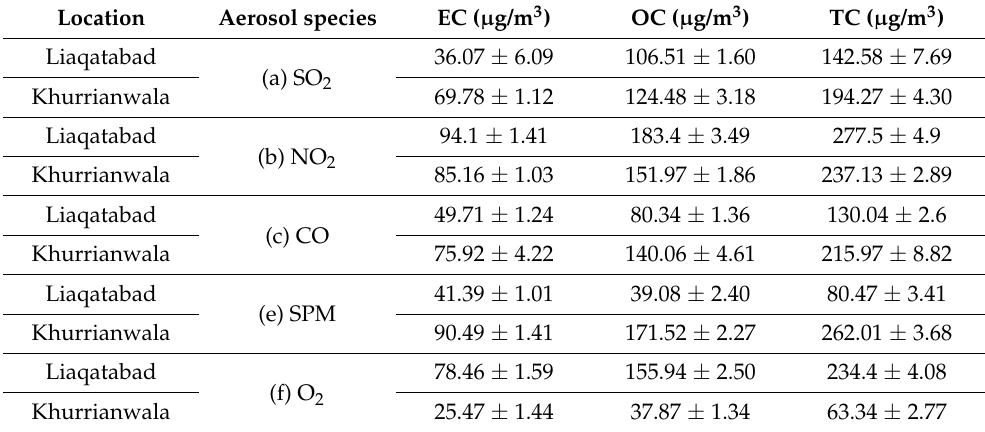
Table 8. Carbonaceous species in air pollutant samples during the winter